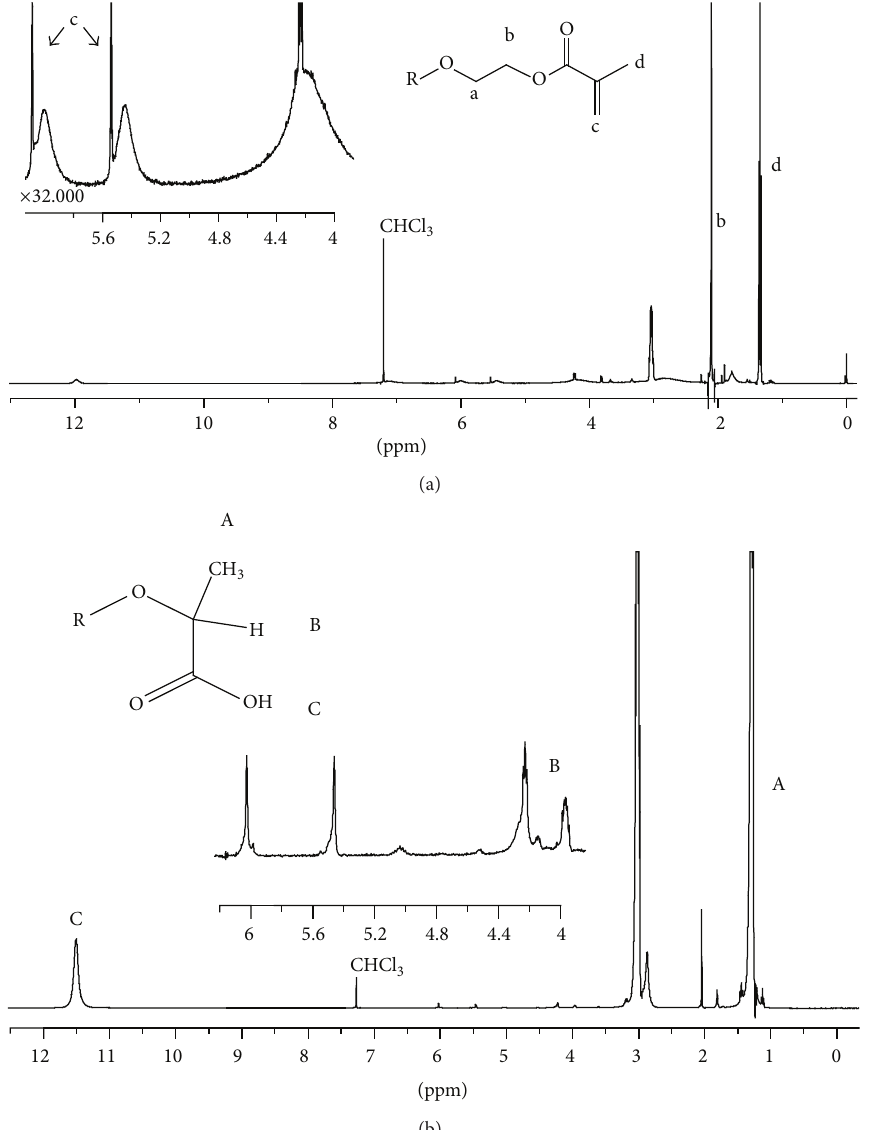
Figure 4: 1 H NMR spectra of (a) PZ-HEMA-1:6 and (b)